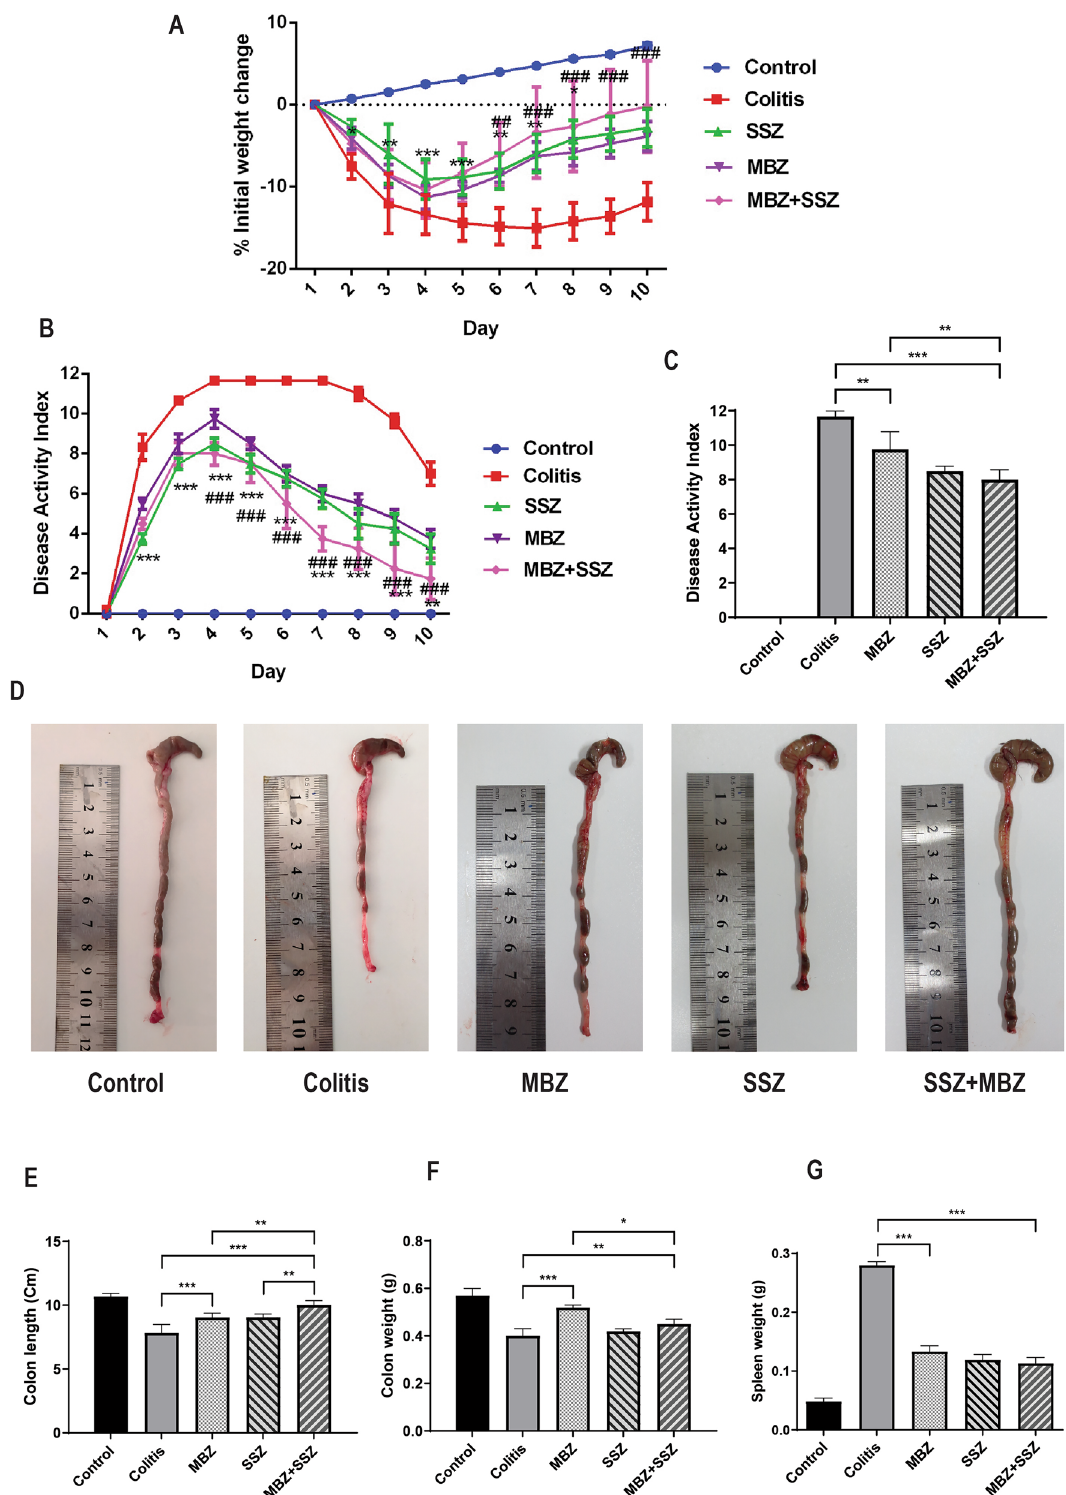
Figure 2. Efficacy of mebendazole on colitis clinical symptoms. ( A ) The effects of MBZ (100 mg/kg/day) alone or in combination with SSZ on body weight loss in DSS-treated mice. ( B ) The inhibitory effect of mebendazole on disease activity index at different time points is presented. ( C ) The highest DAI during the experiment period (10 days) is shown in each group. ( D – E ) MBZ efficacy against DSS-induced colon shortening was evaluated. ( F ) Colon weights and ( G ) spleen weights were measured in different groups. ** P < 0.01, *** P < 0.001. Data were presented as Mean ± SEM, DAI, colon weight and length, and spleen weight were analyzed by one-way ANOVA followed by post-hoc LSD test. Data are representative of three independent experiments with 6 mice in each group (n =